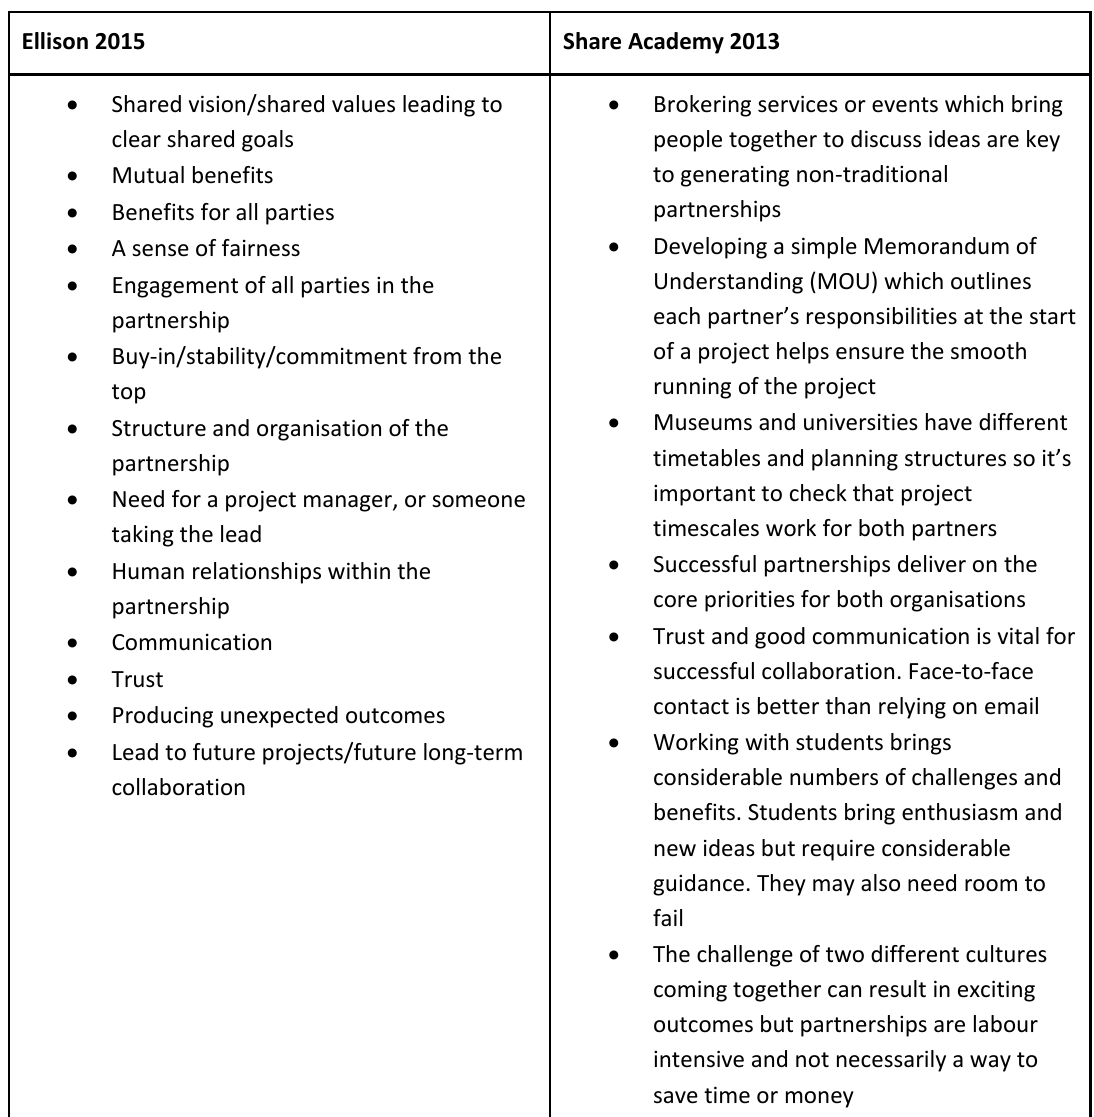
Table 3. Drivers of success and factors contributing to determine failure in museum university partnerships (Share Academy 2013) and in HEIs cultural organisation partnerships (Ellison 2015: